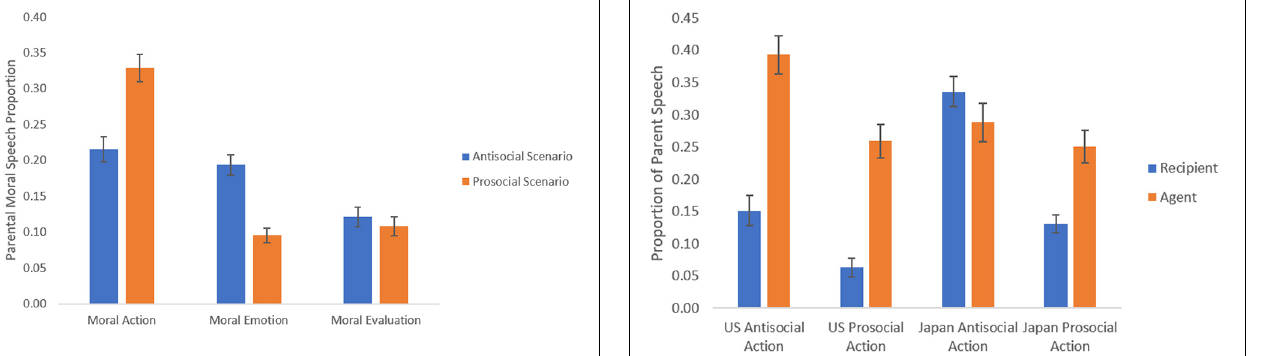
CI: 0.283, 0.370; recipient M = 0.108, CI: 0.078, 0.137),